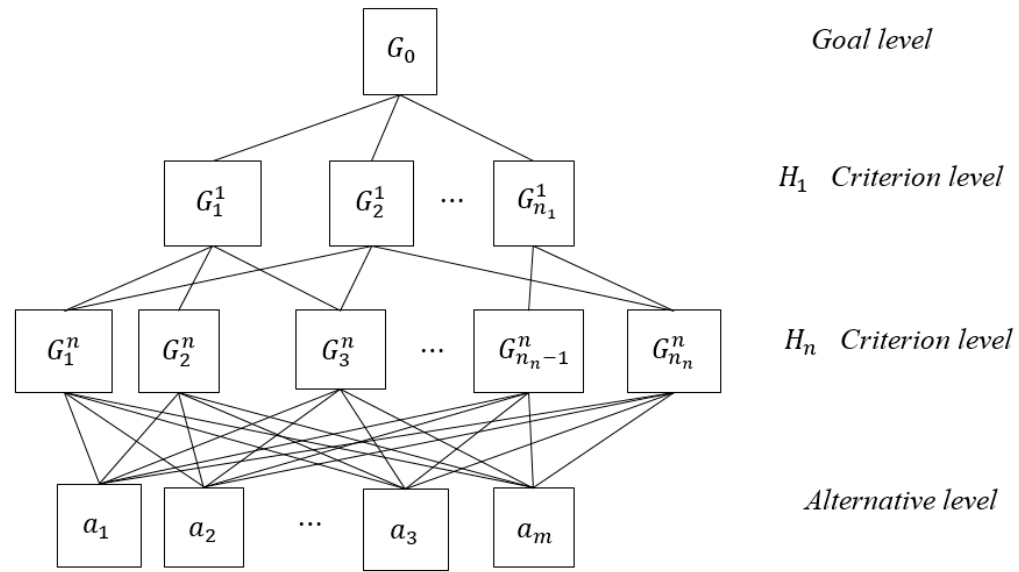
Figure 1. Hierarchical structure.